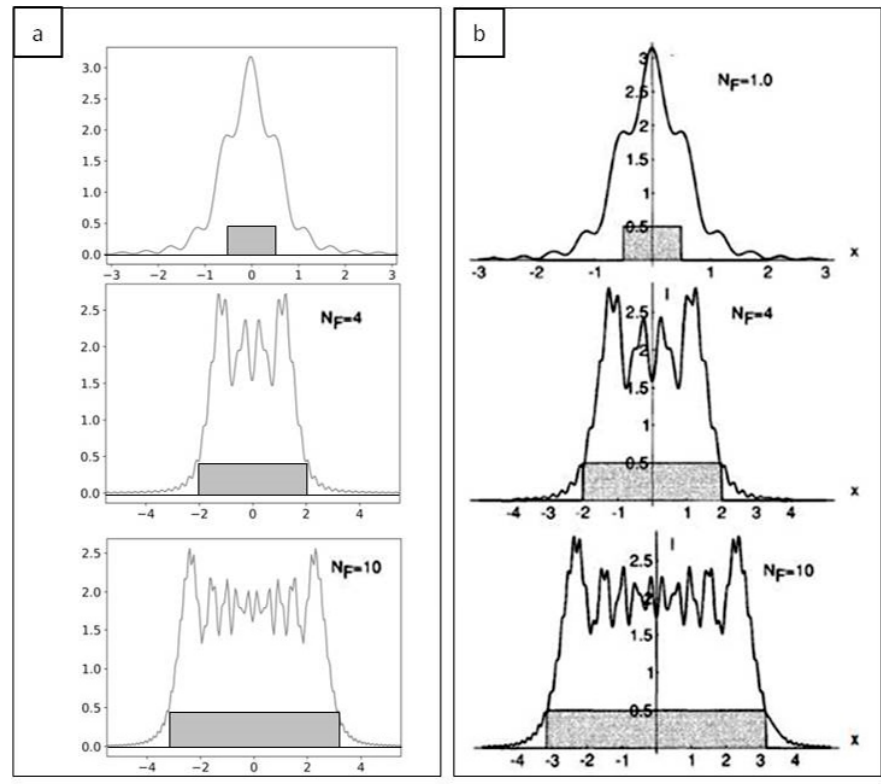
Figure 2. Di ff raction patterns from a rectangular aperture changing the Fresnel number ( N f ). ( a ) Simulation results for N f = 1, 4, 10; aperture size is shown in dark grey. ( b ) Theoretical results for N f = 1, 4, 10; aperture size is shown in dark